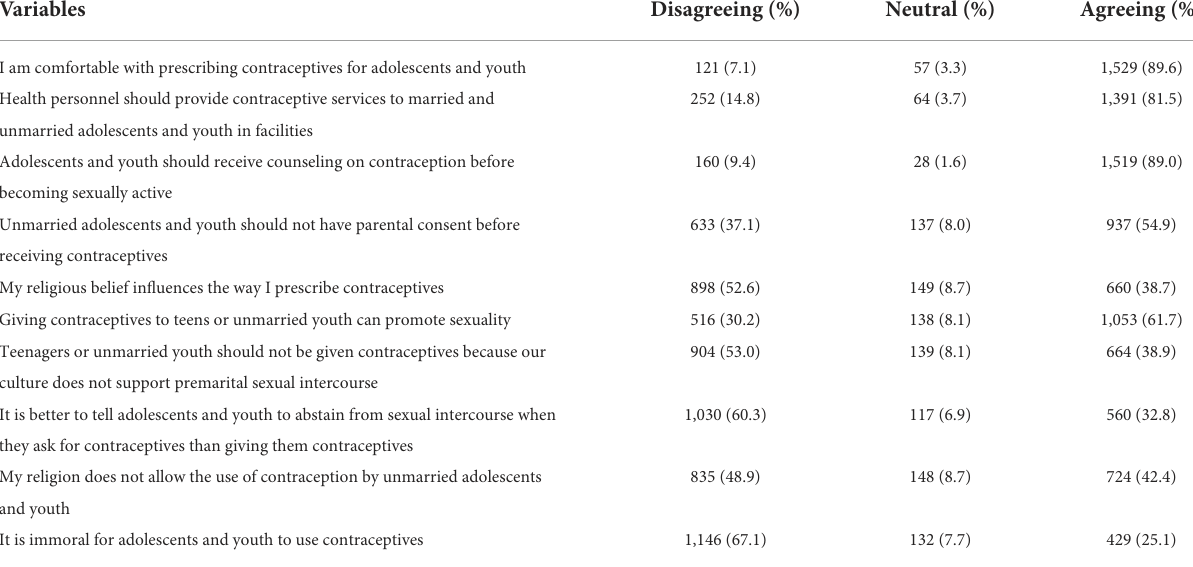
TABLE 3 Providers’ attitudes about contraceptive use among adolescents and youth, Guinea, January-March 2021 ( n = 1,707).